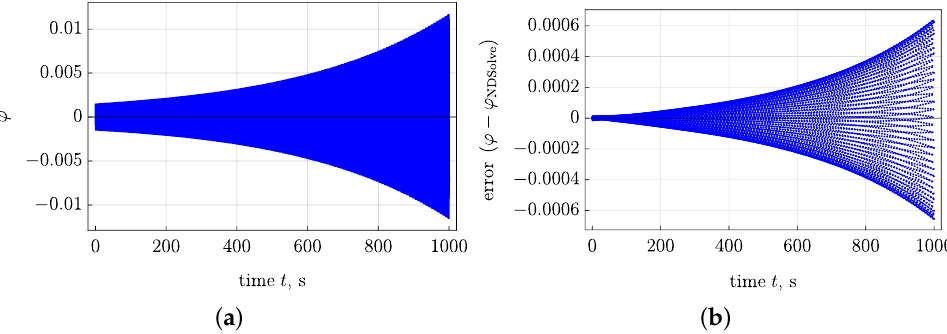
Figure 2. ( a ) Angle ϕ over physical time t for harmonic earthquake excitation in both directions a H0 = 9.81 m/s 2 : our method, the computation time is 0.20 s (three iterations with (4, 6, 9) Taylor terms (for NDSolve of Mathematica the time history is visually indistinguishable and the computation time is 0.94 s). ( b ) Absolute deviation between solutions with our method and